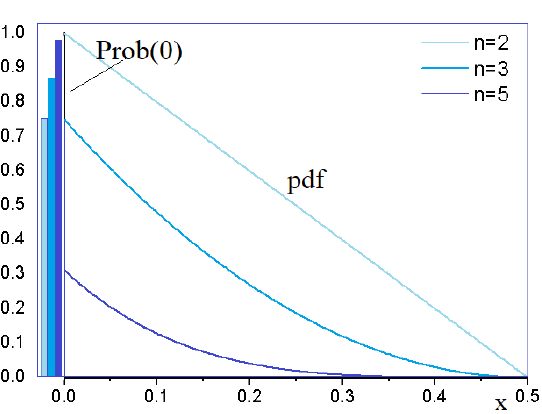
Figure 2. Progress of elitist ES on SPHERE: Dirac (bar) and pdf of continuous part (line)—large step